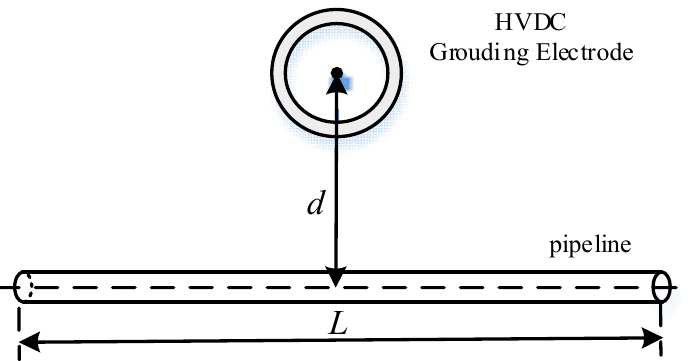
Figure 9. Schematic diagram of the pipeline and HVDC grounding electrode arrangement.